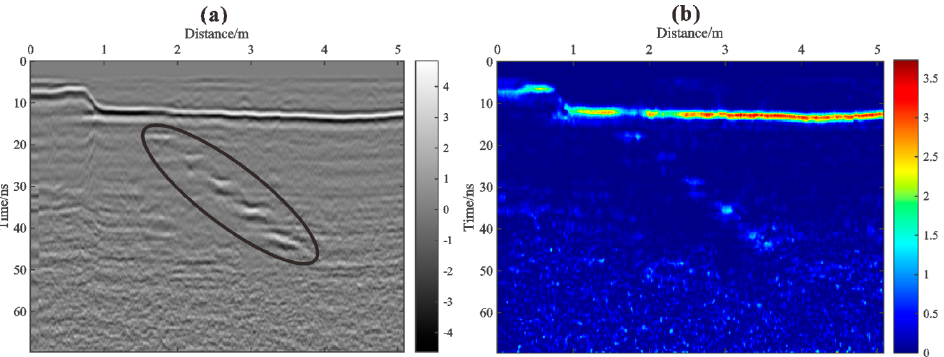
Figure 13. ( a ) B-scan of the field data, where the black circle indicates the voids; ( b ) the profile produced by performing the TKEO directly.